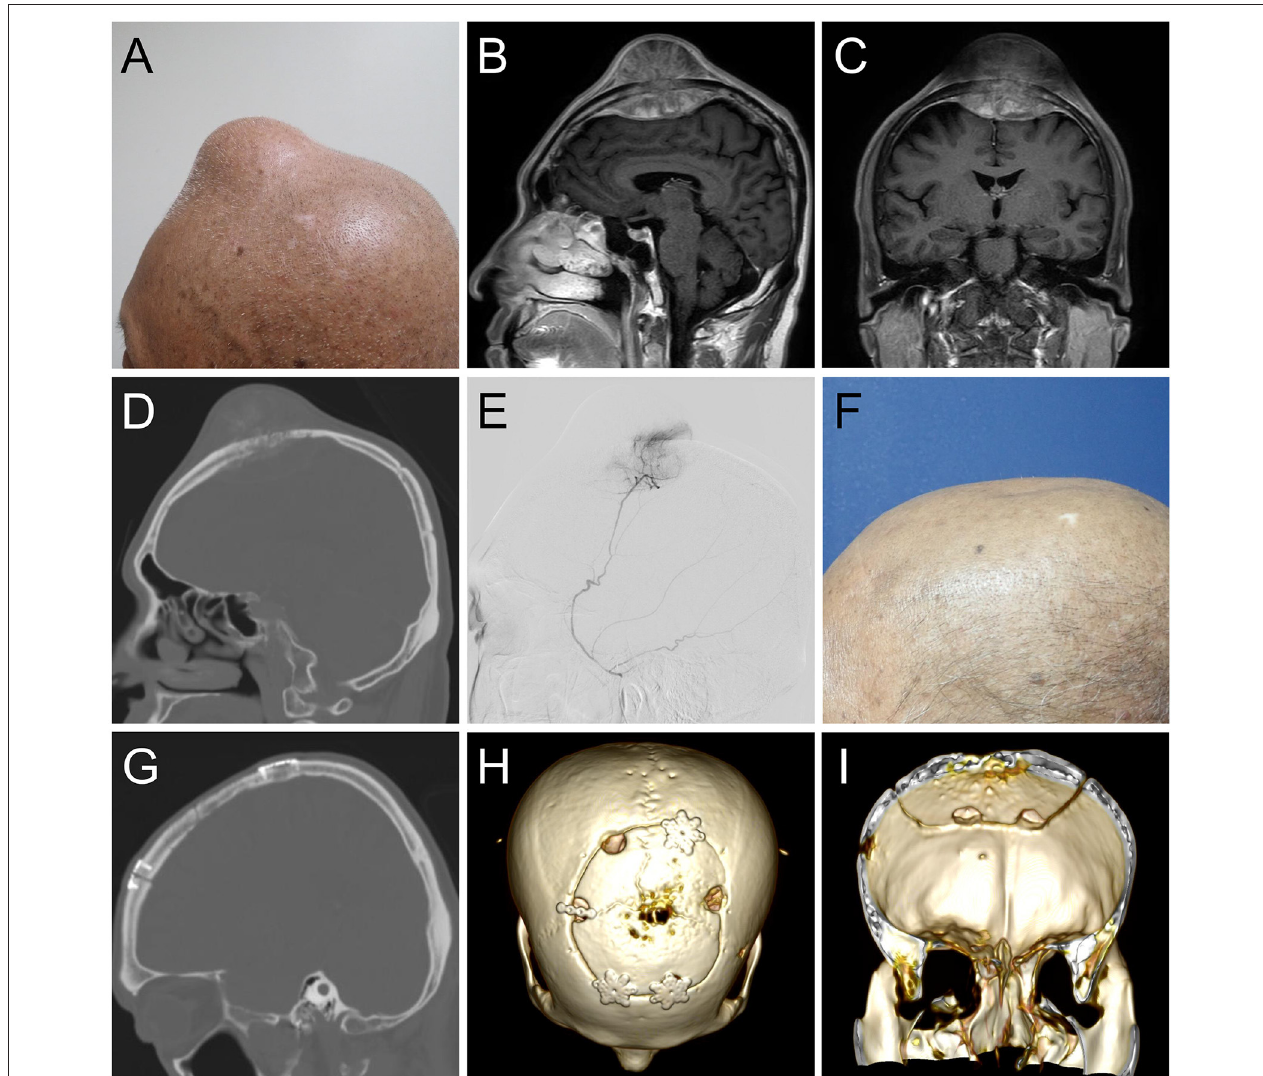
FIGURE 1 | (A) Clinical image of the 8-cm scalp tumor. (B) Sagittal and (C) coronal gadolinium-enhanced T1- weighted magnetic resonance imaging depicting a biconvex mass with extracranial and intracranial invasion, compressing bilateral brain tissue. (D) A sagittal computed tomography (CT) image showing an osteoblastic lesion. (E) Angiographic tumor staining of the left middle meningeal artery. At the 6-month follow-up (E) , sagittal and coronal CT (F,G) and 3D reconstruction image (H,I) illustrated normal skull contour with a solid fusion of the graft to the